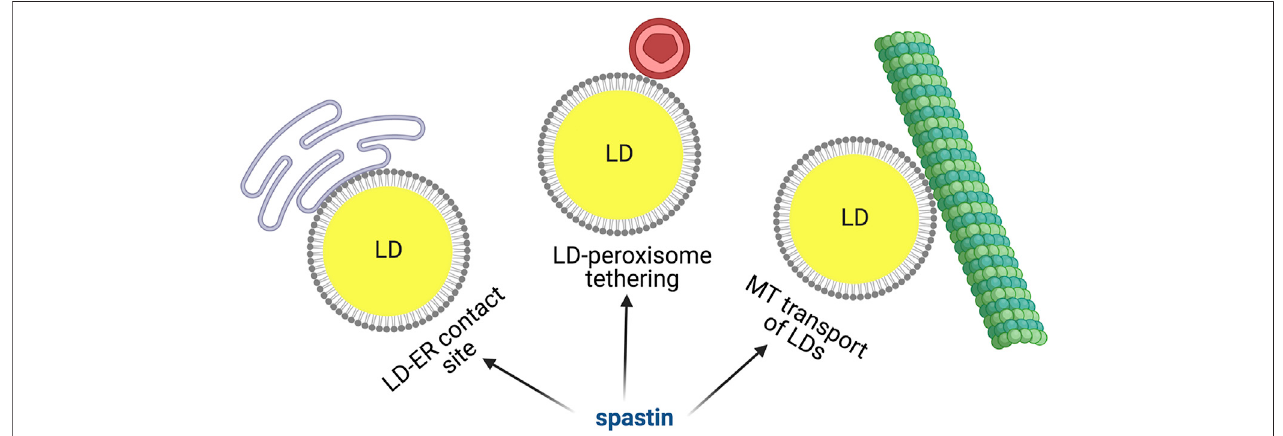
FIGURE3| SpastinM1andLDfunction.SpastinisinvolvedinmediatingER-LDcontacts,LD-peroxisometetheringandLDmovementviamicrotubules.Madewith